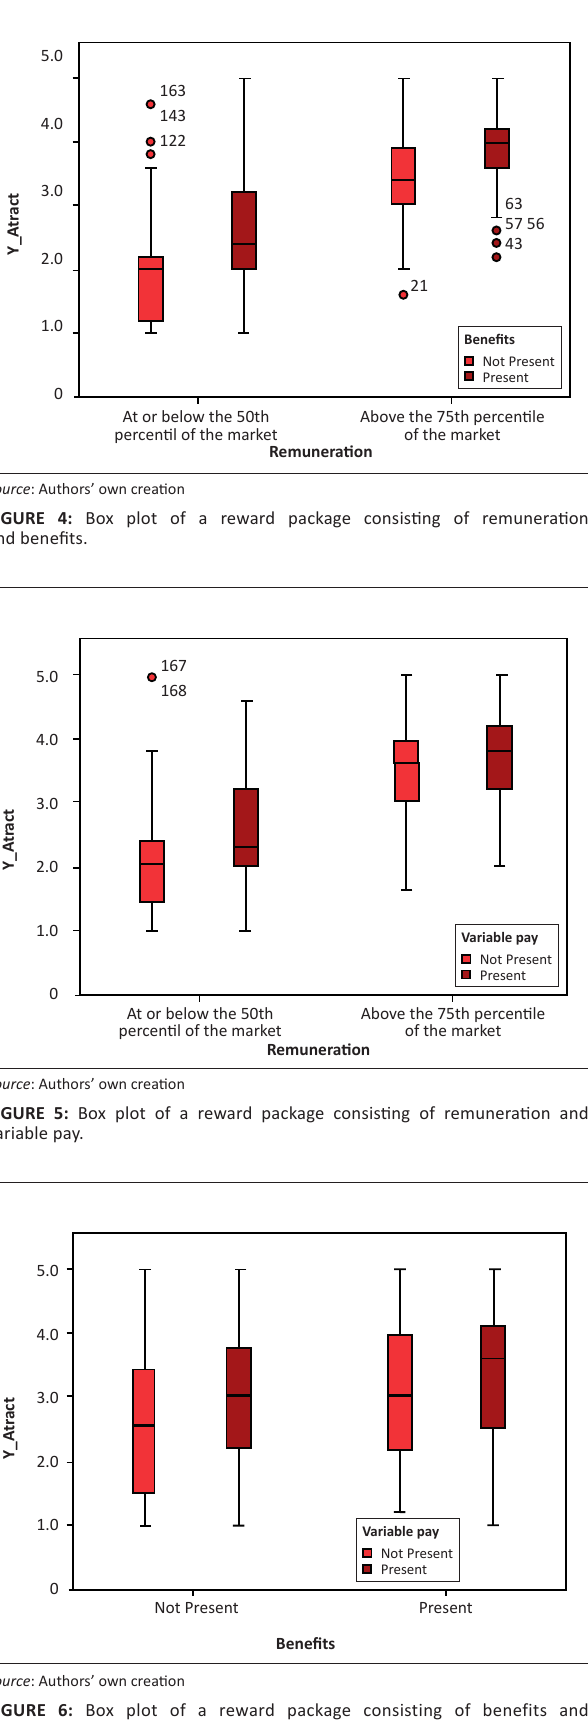
FIGURE 3: Comparison of the means for perceived job attractiveness based on two levels of variable pay.